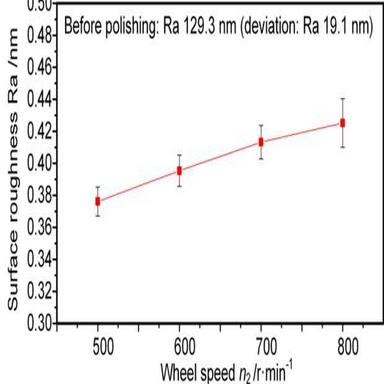
Measured average surface roughness versus wheel speed.